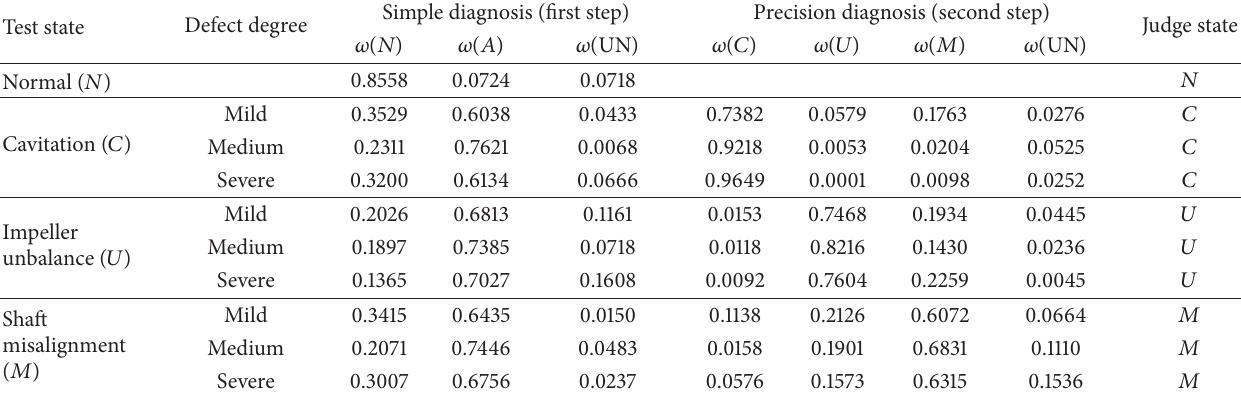
Table 6: The diagnostic results of various states with the defect degrees by the proposed